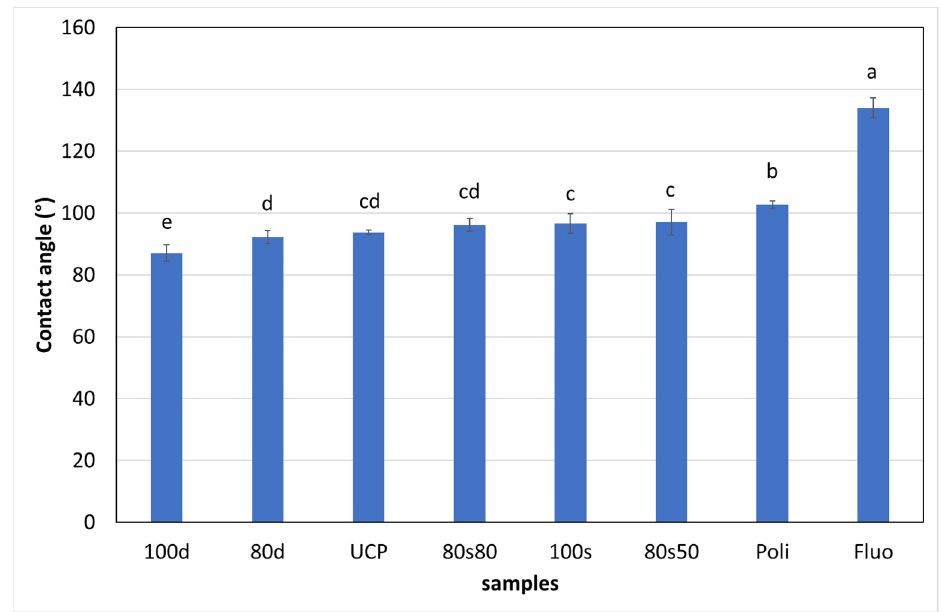
Figure 7. Average water contact angle values for first set samples. Error bars report standard deviation. Different letters indicate statistically significant differences ( p < 0.05). “UCP” refers to base paper, “Fluo” to fluorinated paper, while “Poli” to polyethylene-coated paper. See Table 1 for other samples codification.